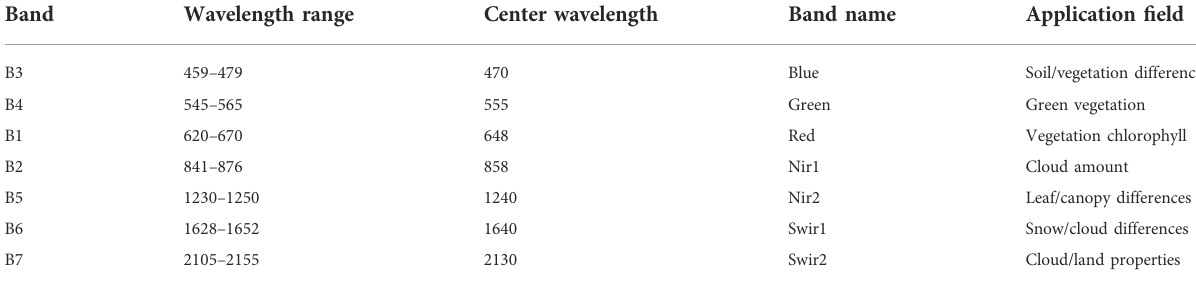
TABLE 2 MOD09A1 seven bands and their main application fi